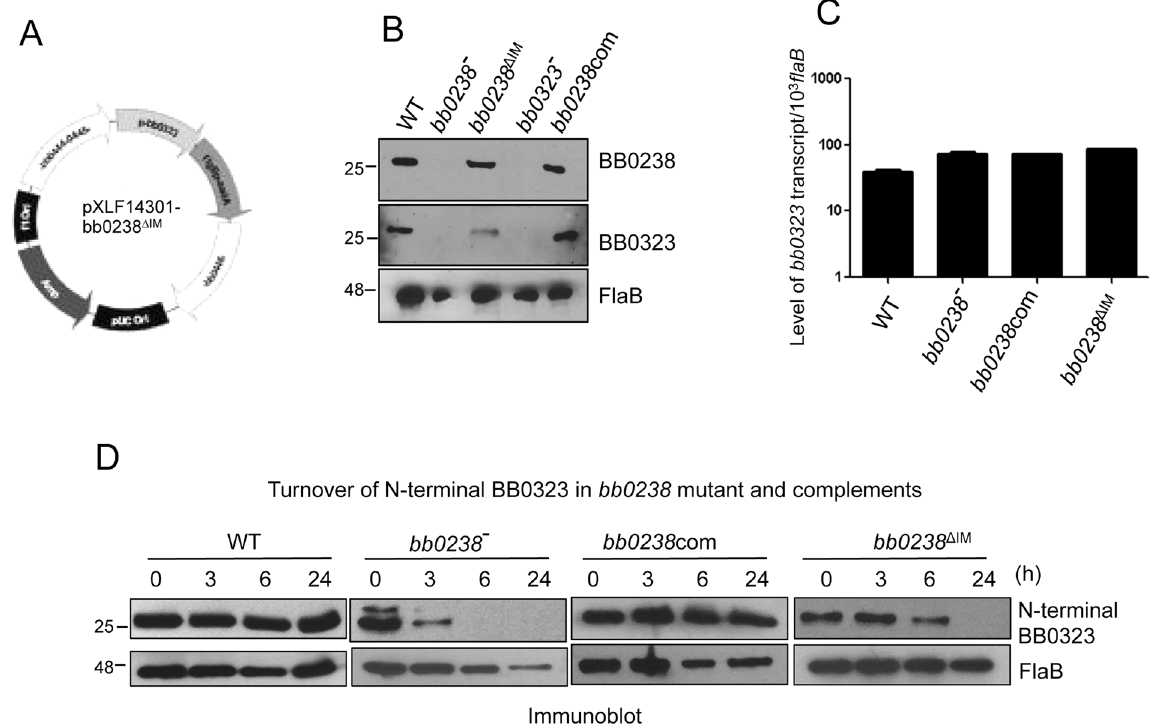
Figure 4. The interaction with intact BB0238 is required for the stability of BB0323 in B . burgdorferi . ( A ) Diagram of vector construct (pXLF14301- bb0238 ∆ IM ) for chromosomal insertion of bb0238 ∆ IM . The construct was created by deletion mutagenesis of the previously used bb0238 complement construct 16 . ( B ) Production of BB0238 and BB0323 proteins by the bb0238 ∆ IM complemented B . burgdorferi . Lysates of wild type (WT), bb0238 mutant (bb0238 − ), bb0238 complement (bb0238com), bb0238 ∆ IM complement (bb0238 ∆ IM ) and bb0323 mutant (bb0323 − ) B . burgdorferi were separated by SDS-PAGE, transferred on nitrocellulose membrane and blotted with antiserum against BB0238 (upper panel), BB0323 (middle panel) and FlaB (lower panel). ( C ) Expression of BB0238 ∆ IM did not alter the transcript level of bb0323 . The level of bb0323 transcripts relative to flaB in WT, bb0238 mutant, bb0238 complement and bb0238 ∆ IM complement was measured by qRT-PCR. ( D ) Posttranslational stability of BB0323 in WT, bb0238 mutant, bb0238 and bb0238 ∆ IM complemented B . burgdorferi . Protein synthesis was inhibited by the addition of 100 µ g/ml spectinomycin to growing cultures of spirochetes, and levels of N-terminal domain of BB0323 were determined by immunoblot analysis. At indicated time points, spirochetes were collected, lysates were separated by SDS-PAGE and immunoblotted using anti-BB0323 and anti-FlaB (loading control) antisera. Migration of protein standards is shown to the left in